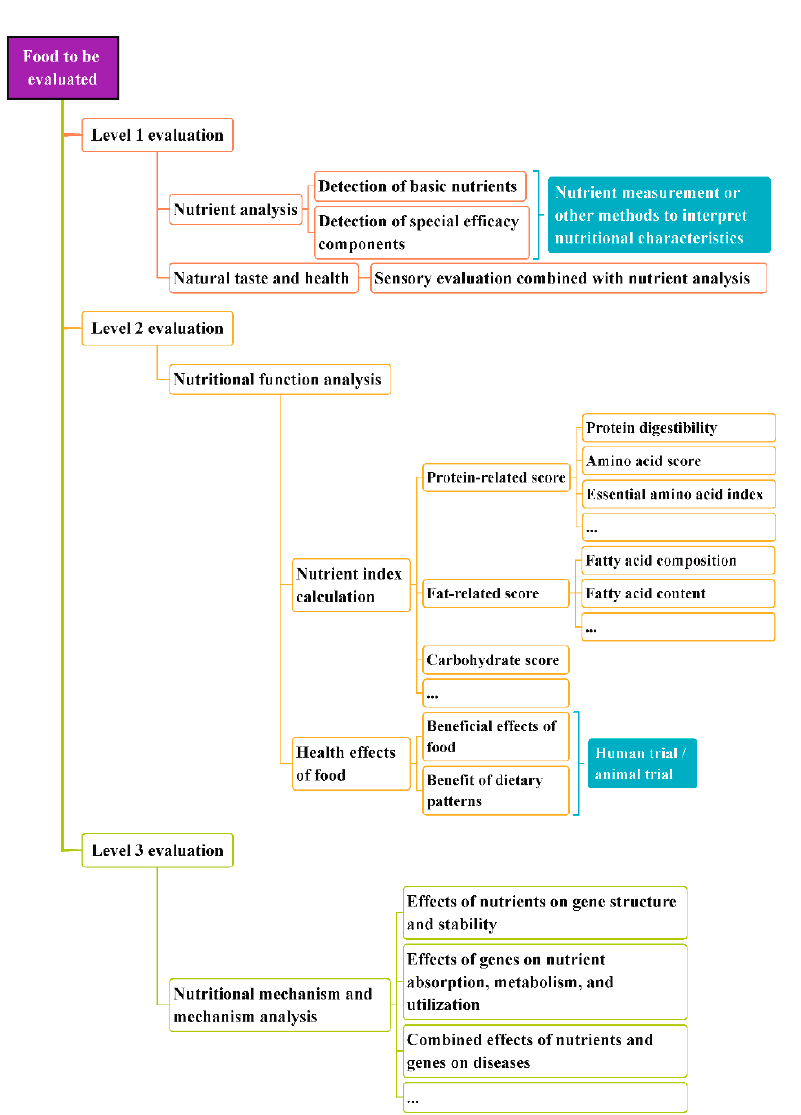
Figure 4. Levels of nutritional value evaluation procedures.